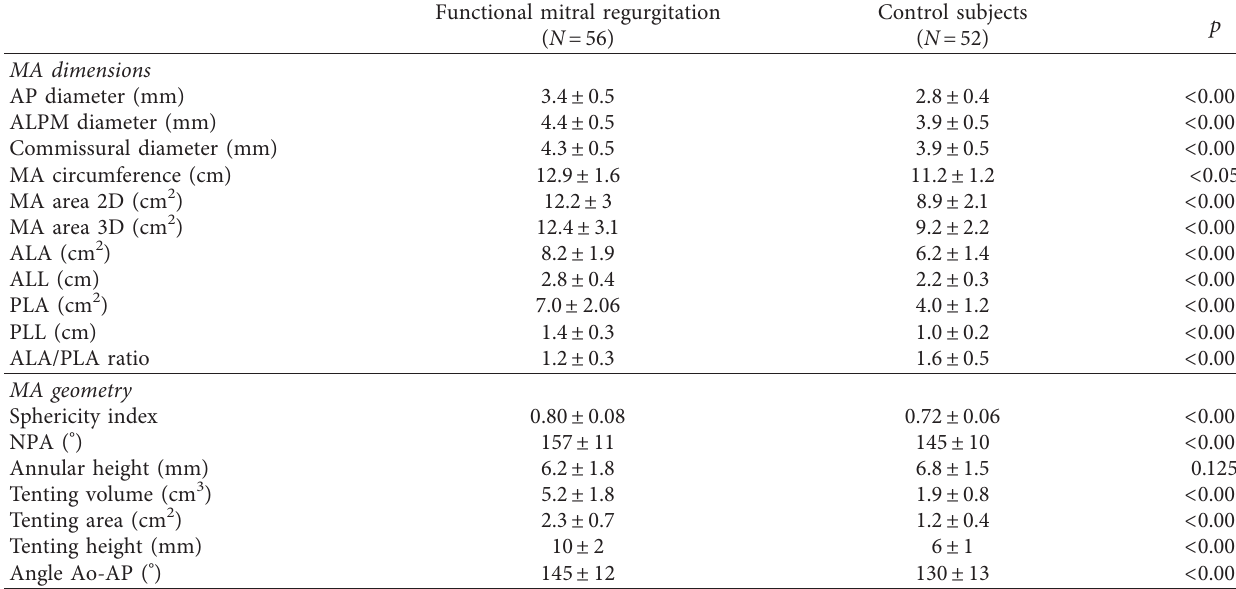
Table 2: Comparison of the mitral annulus parameters, measured at mid-systolic frame, between patients with functional mitral re- gurgitation and control